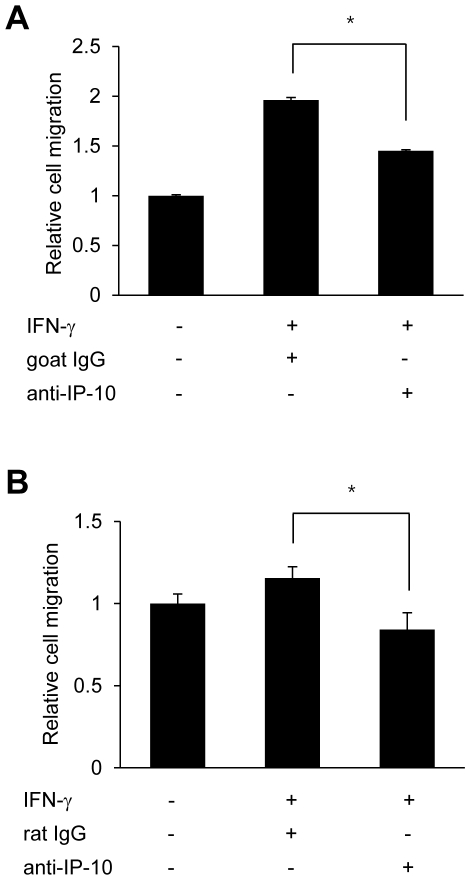
IP-10 Neutralization Inhibits the Migration of T Cells.(A) SNU-638-Pml siRNA cells were grown in the absence or presence of IFN-γ (10 ng/ml) for 8 h, and supernatant was collected and pretreated with IP-10 neutralizing antibodies (5 µg/ml) or IgG (5 µg/ml) for 1 h prior to initiation of the transwell migration assay. The number of migrating Jurkat cells obtained from the lower chamber was analyzed by fluorescent count-bead mediated counting on a flow cytometer. (B) Transwell migration of EL-4 cells to culture supernatants from NIH3T3 cells transiently transfected with Pml siRNA in the presence of neutralizing IP-10 antibody or IgG control. Relative cell migration was determined by the number of the migrated cells divided by the number of cells migrating to supernatants without IFN-γ, and the value from parental cells was arbitrarily set at 1. Data shown are representative of at least three experiments. Bars, SD. *P<0.05.